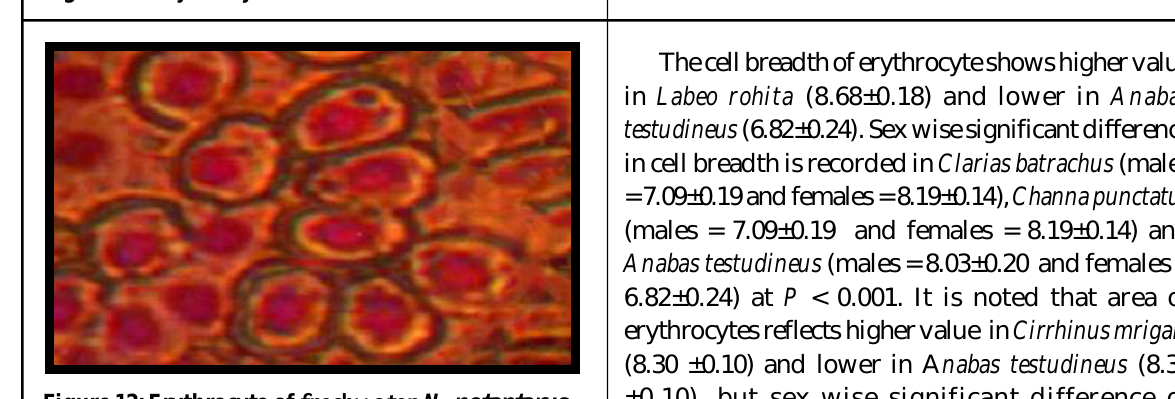
Figure 10: Erythrocyte of freshwater O. niloticus Figure 11: Erythrocyte of freshwater A.testudineus